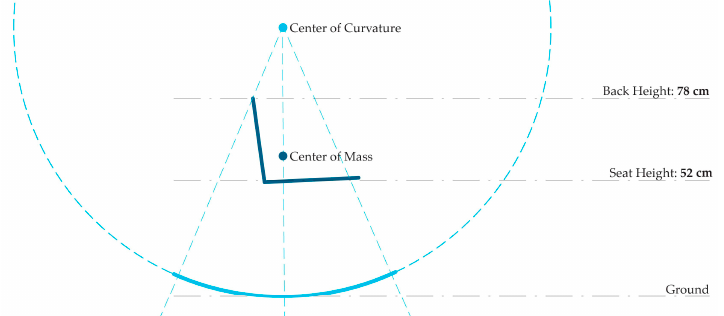
Figure 7. Curvature, ergonomics, and rocking chair functionality curve diagram.